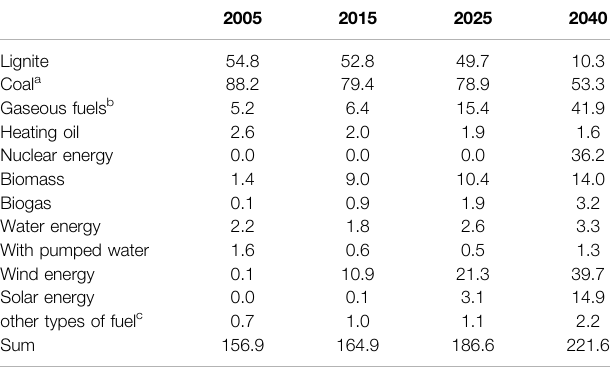
TABLE 1| Gross electricity production inPoland byfuel(TWh) (Piech et al.,